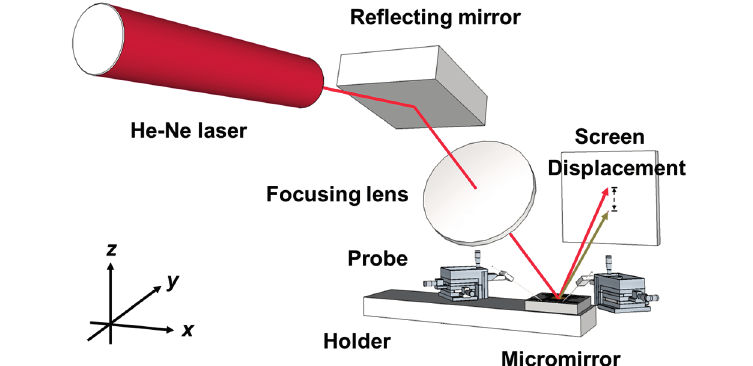
Figure 8. Schematic drawing of the experimental setup for tracing the light spot of the reflected laser